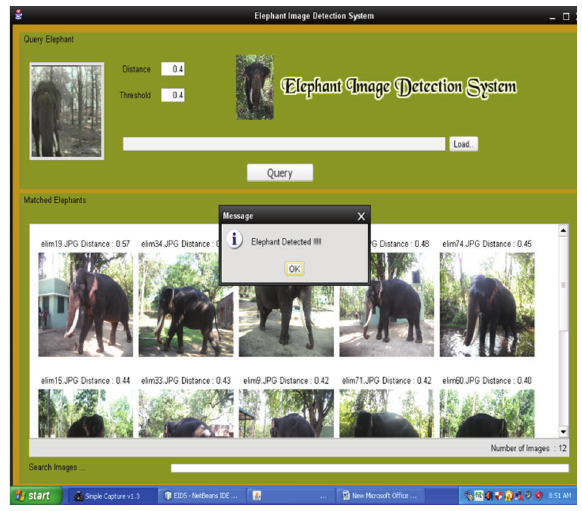
Figure 4: Retrieved online elephant image. Figure 5: 3 Level decomposed query elephant image.